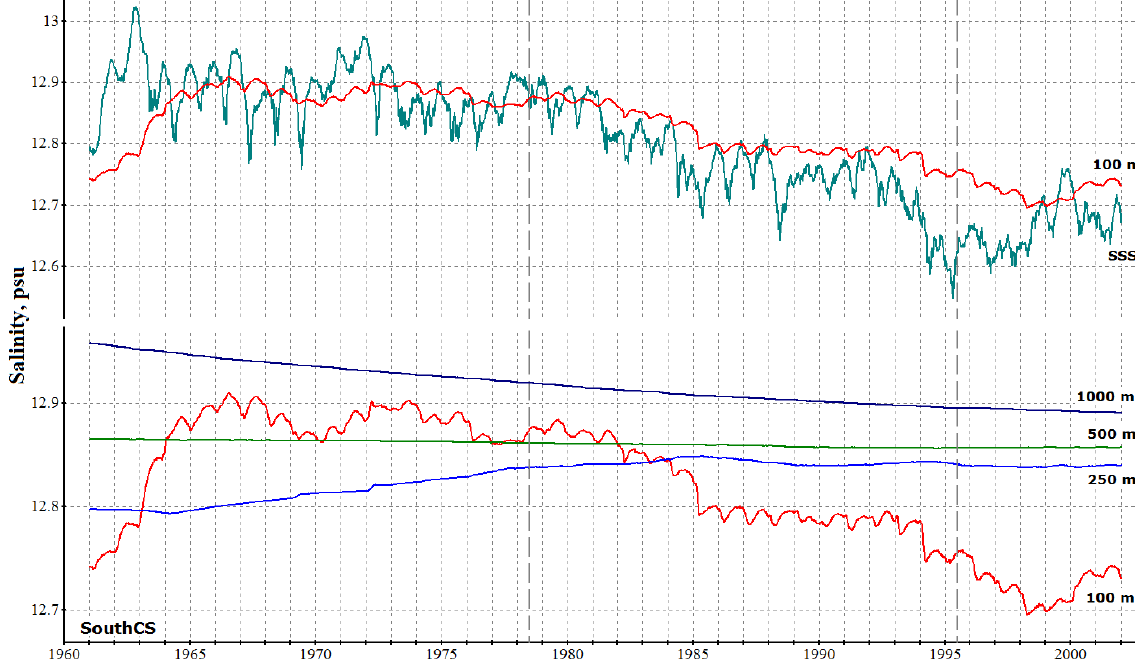
Figure 12. Evolution of salinity (psu) at different depths averaged over the SouthCS basin.